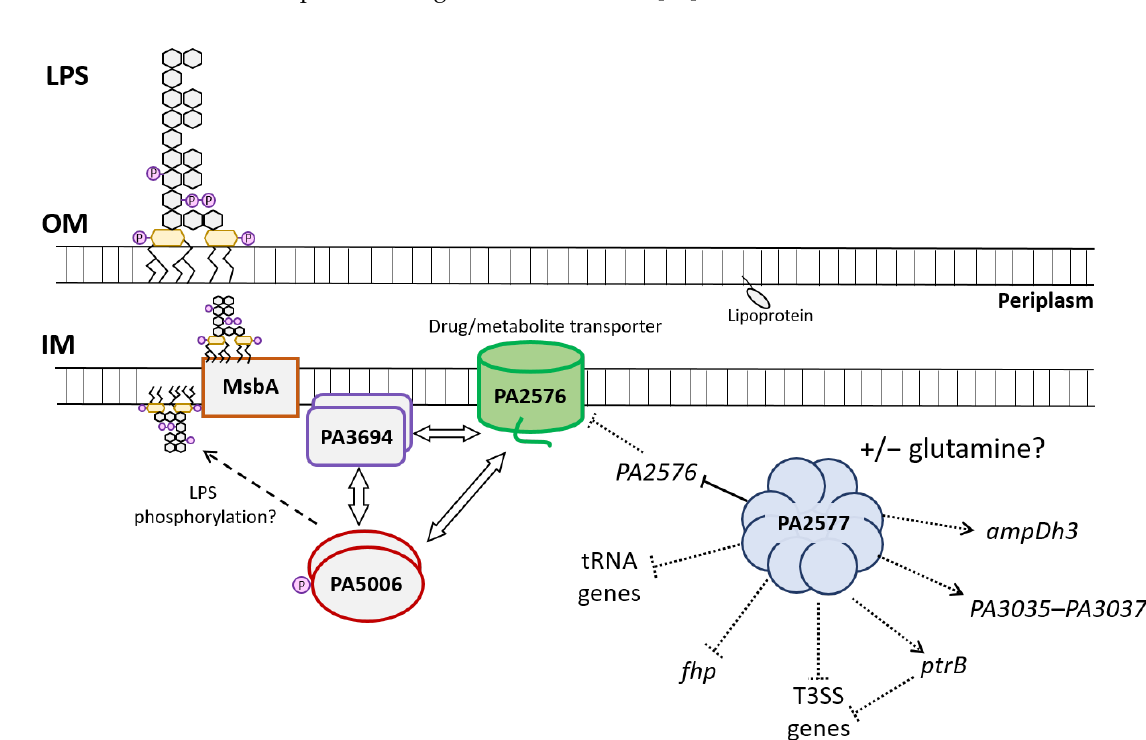
Figure 7. Schematic picture presenting relationships between PA2577 regulator, PA2576 transporter and partners of PA2576 probably existing in dimeric forms in the cytoplasm. PA2577 regulator is presented as an octamer. IM—inner membrane; OM—outer membrane; LPS—lipopolysaccharide. A solid line indicates direct repression by PA2577; dotted lines indicate direct and/or indirect involvement of PA2577 in gene expression control.